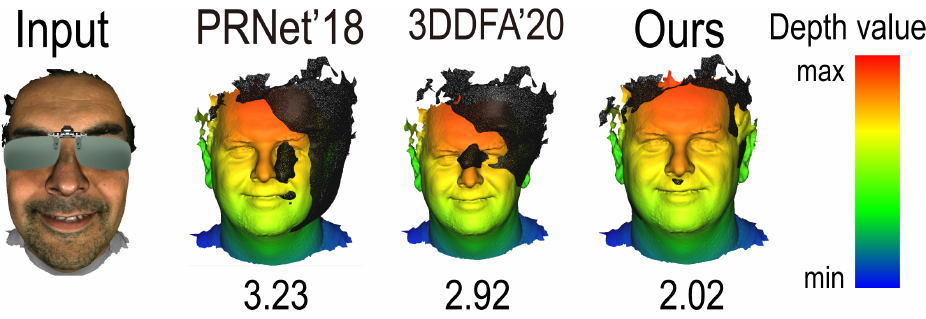
Figure 4. Comparison of error heat maps on the 3D shape recovery on MICC Florence datasets. Digits denote 90% error